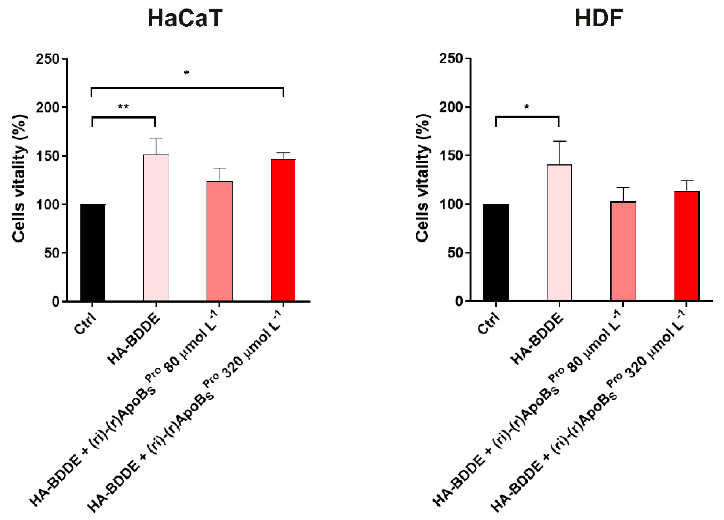
Figure 7. Effects of HA-BDDE hydrogel system functionalized with the peptidomimetic on human eukaryotic cell lines. Effects of HA-BDDE hydrogel system loaded with different concentrations of (ri)-r(P)ApoB SPro on the viability of HaCaT (immortalized human keratinocytes) and HDF (human dermal fibroblasts) cells. Cell viability was assessed by MTT assays and expressed as the percentage of viable cells compared to untreated cells (control). Experiments were performed three times. Error bars represent the standard deviation of the mean. Significant differences were indicated as * p < 0.05 or ** p < 0.01, for treated vs. control samples.